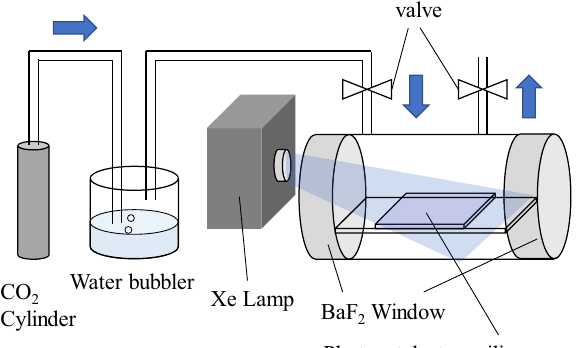
Fig. 1 Schematic diagram of the photocatalytic reaction testing Fig. 1, each photocatalyst sample deposited on a silica filter paper was placed in the center of a cylindrical cell (with a diameter of 3 cm, length of 10 cm, and volume of 60 mL) sealed with BaF windows on both sides. CO 2 2